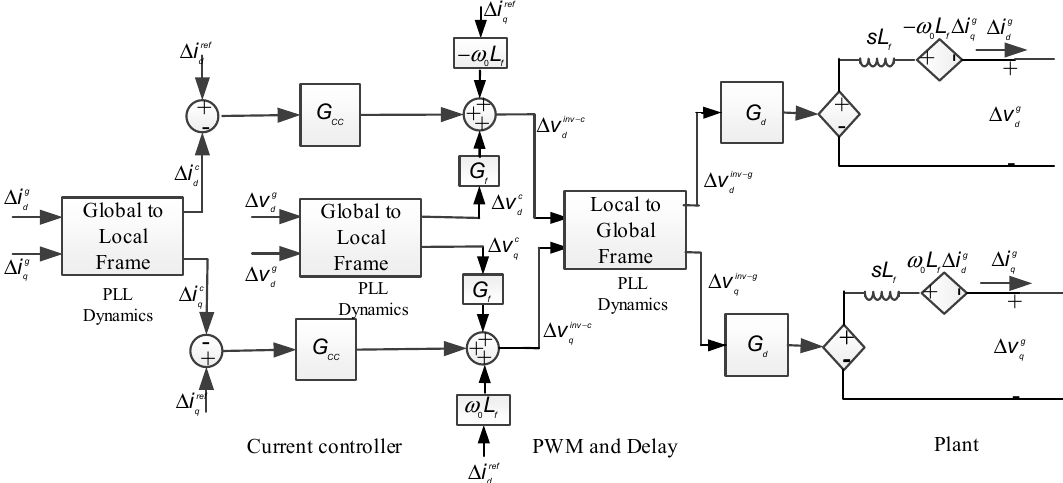
Figure 3. Dq small signal model of the current controller, PLL and the filter inductance (L f ).